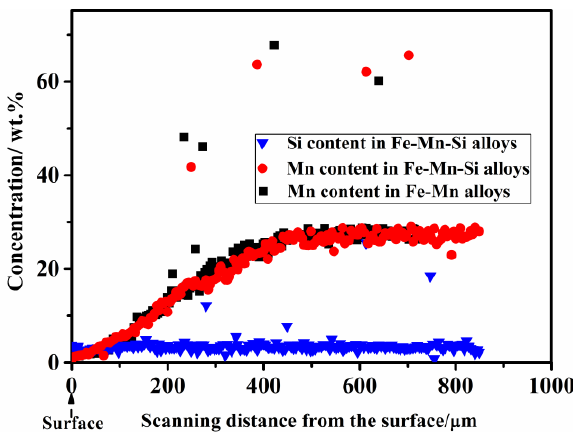
Figure 1. The Fe, Mn and Si concentration in Fe–Mn-based alloys as a function of EDS scanning distance from the surface of the cross-section of the sintered alloys at 1200 °C for 3 h. Table 1. Thickness of Mn depletion region and average chemical composition of the sintered Fe– Mn-based compacts at 1200 °C for 3 h.